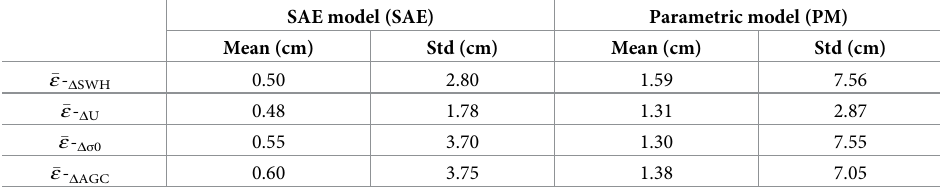
Table 1. Residual error analysis of the SAE model and the parametric model.